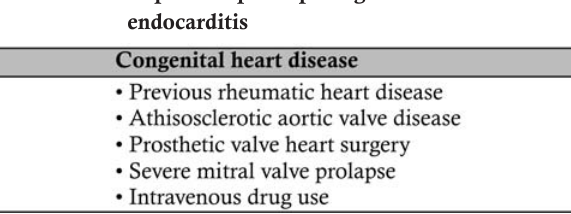
Important predisposing factors for infective